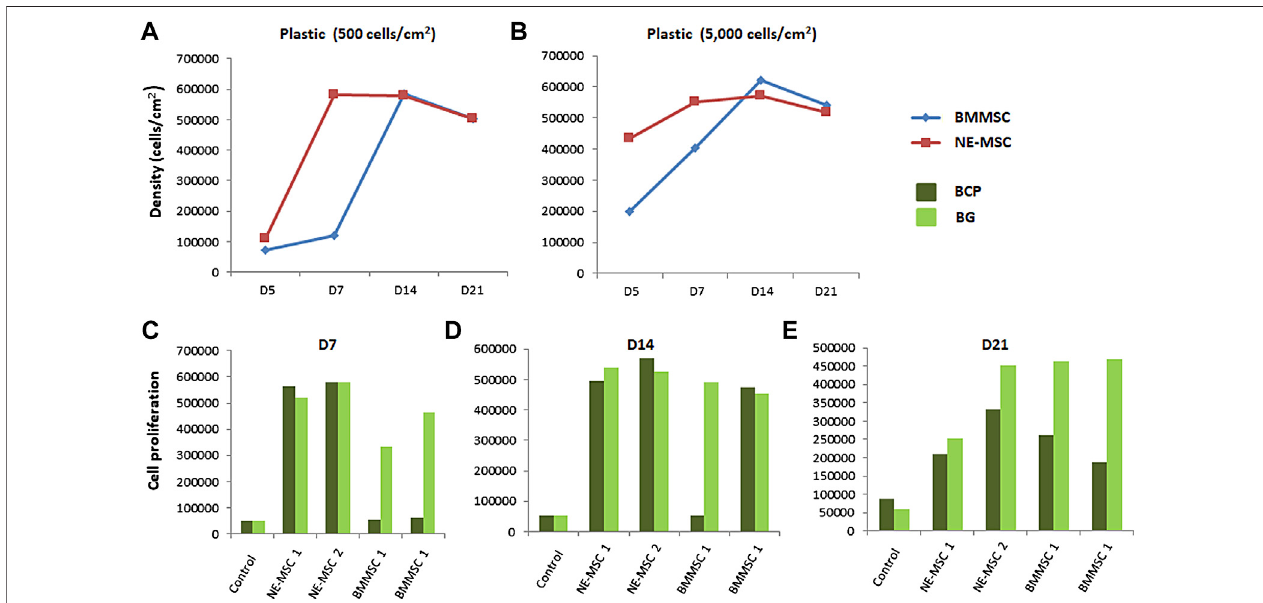
FIGURE 4 | In fl uence of the biomaterial on cell proliferation. BMMSCs and NE-MSCs were seeded on 2D plastic at two different densities: 500 (A) and 5,000 cell/ cm 2 (B) , on BCP and BP biomaterials (C – E) , and cell metabolic activity monitored over a period of 3 weeks using alamarBlue ® assay. On plastic, BMMSCs and NE- MSCs display a high proliferation rate. On plastic and on both biomaterials, NE-MSCs proliferate more rapidly than BMMSCs. BG biomaterial favors BMMSC proliferation. Controls correspond to cell-free biomaterials (background noise of alamar blue).